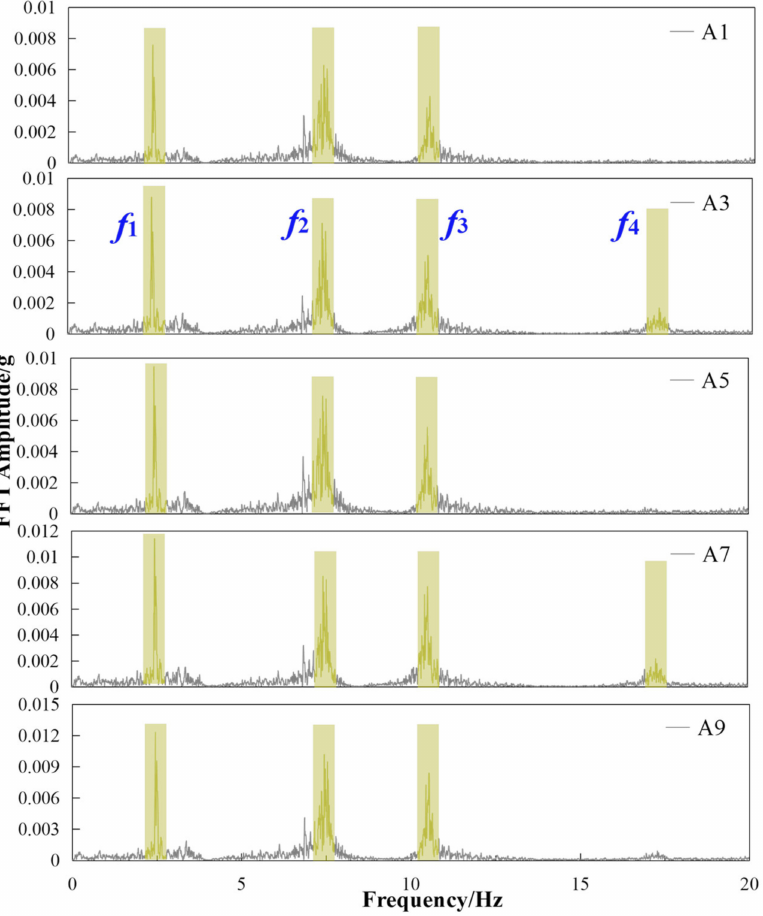
Figure 13. Acceleration time history of different measuring points at the slope